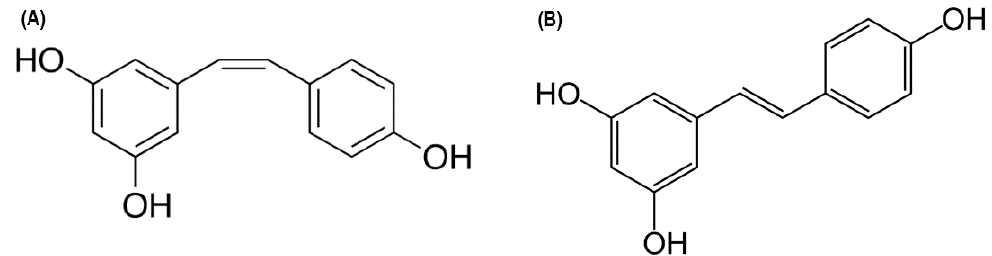
Figure 1. ( A ) cis-resveratrol; ( B ) trans-resveratrol.